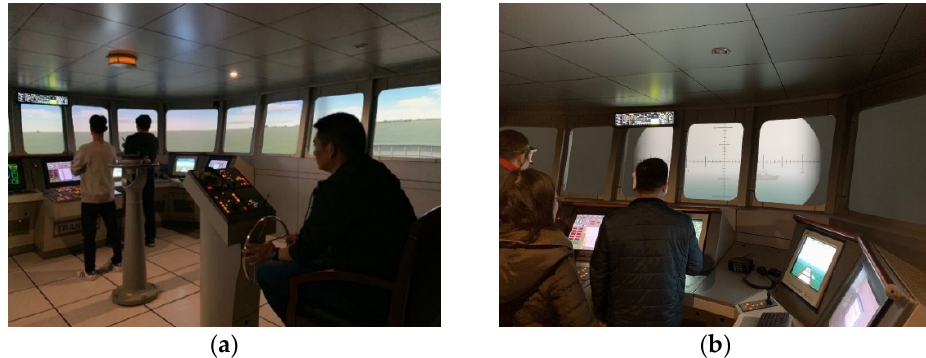
Figure 3. The test subjects and staff in the experiment ( a ) staff in adjusting bridge simulation ( b ) subjects in the experiment.